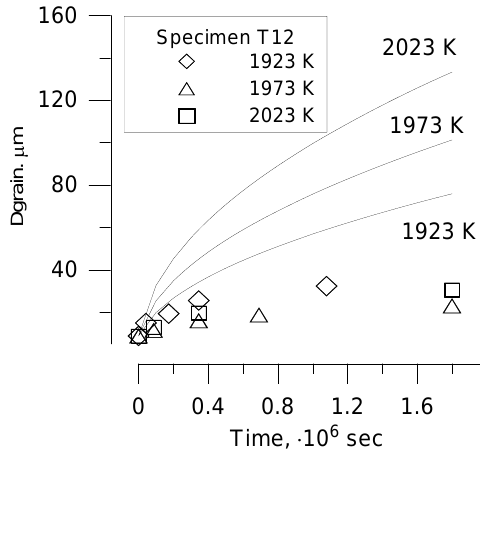
Figure 8. MFPR simulations of Bourgeois’ tests. Standard model for normal grain growth neglecting retarding effect of